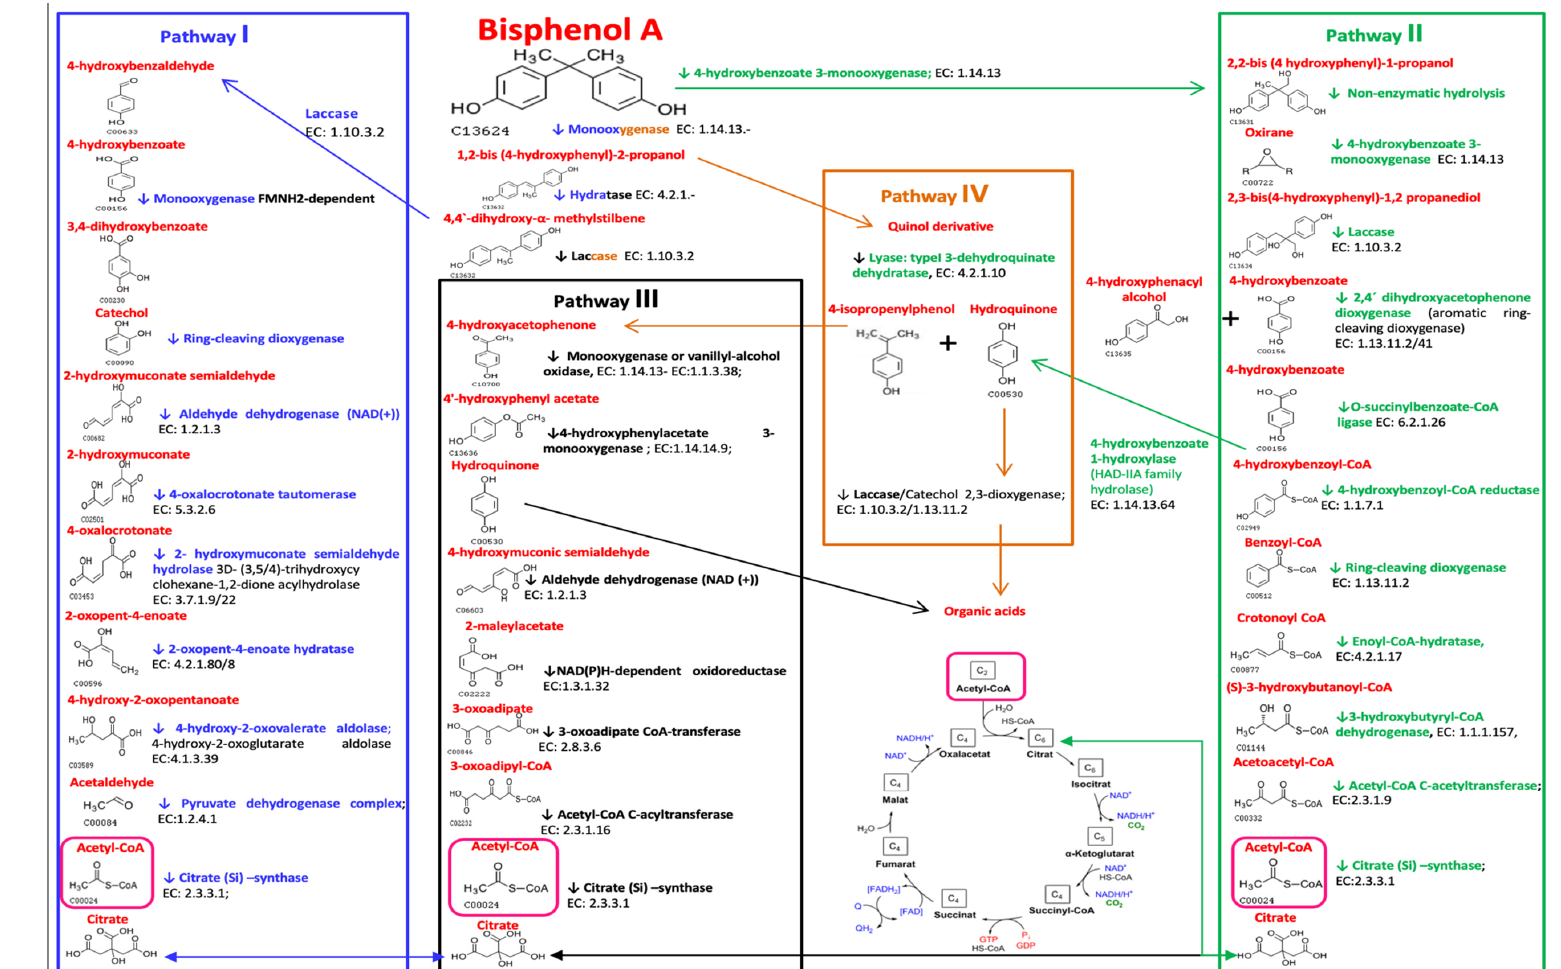
Figure 2. Bioinformatics and molecular predictive analysis; ( a ) percentages of BPA genes of the four different pathways present on WGS T from the major isolated representative microbiota taxa, ( b ) biodegradation pathways of BPA.